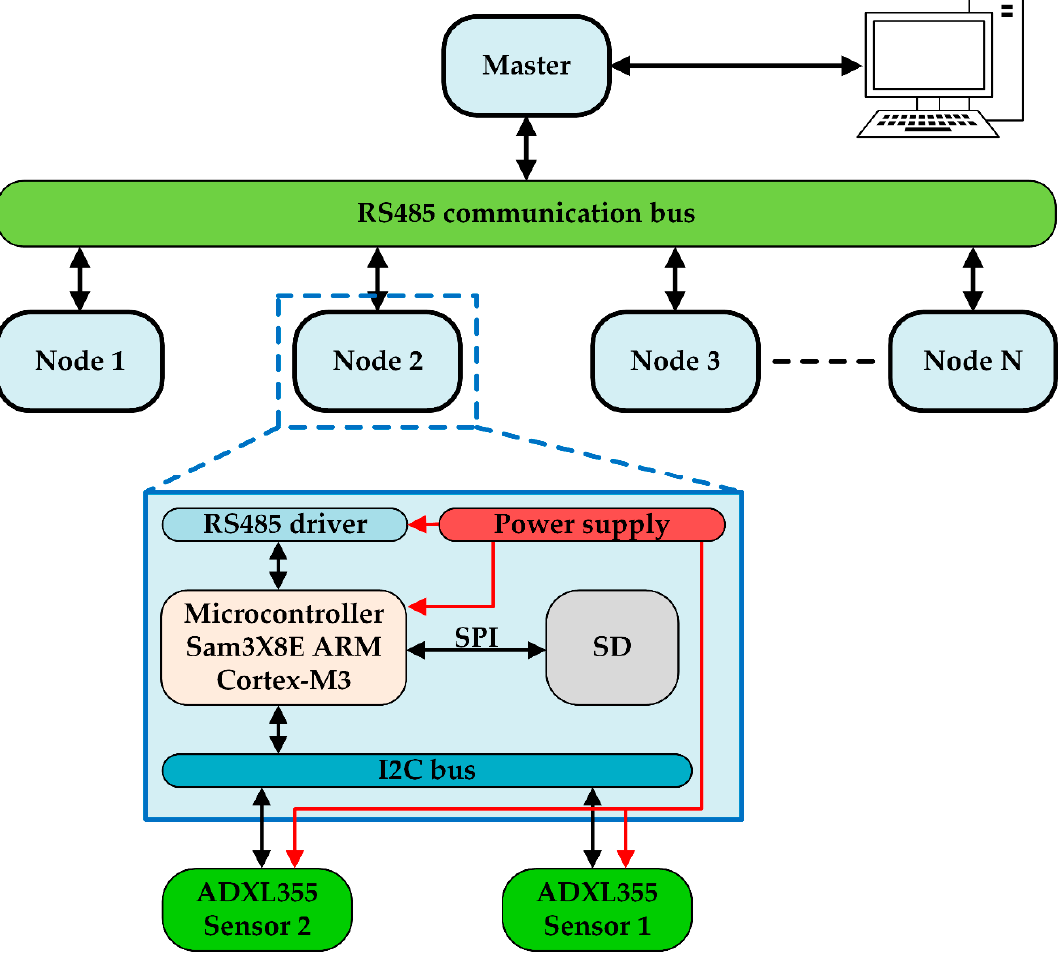
Figure 2. The scheme of the proposed monitoring system. In this scheme, the architecture of the node is